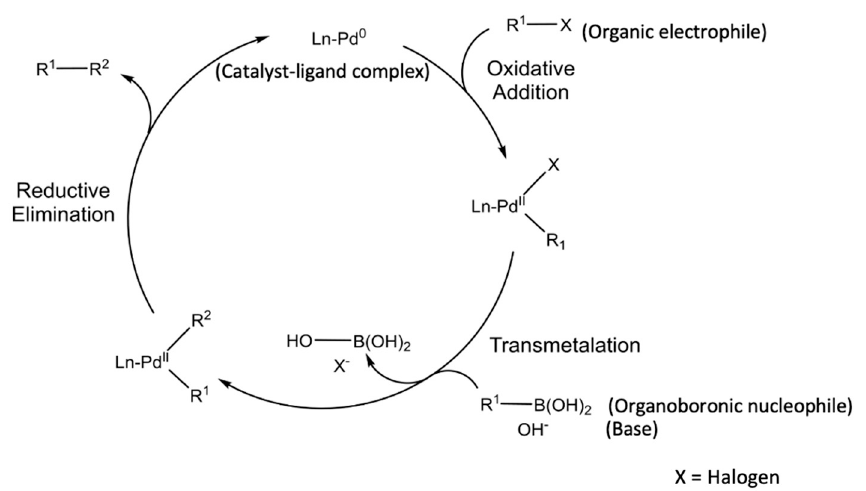
Figure 1. Catalytic cycle of the Suzuki coupling reaction